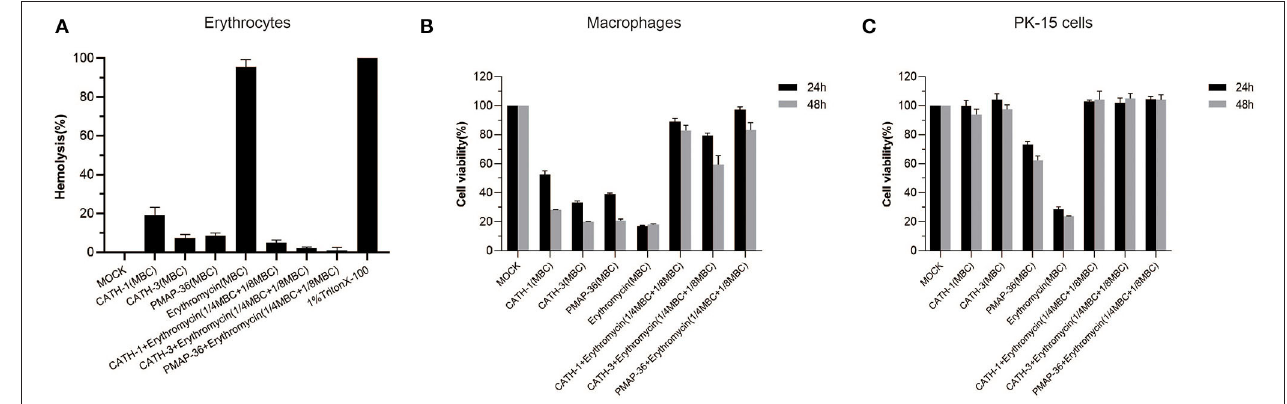
FIGURE 3 | Hemolytic activity and cytotoxicity of antimicrobial peptides combination with erythromycin. Hemolytic activity of CATH-1, CATH-3, and PMAP-36 combination with erythromycin to the red blood cells of mice (A) . Cell viability of peritoneal macrophages (B) and PK-15 cells (C) treated with CATH-1, CATH-3, and PMAP-36 combination with erythromycin according to WST-1